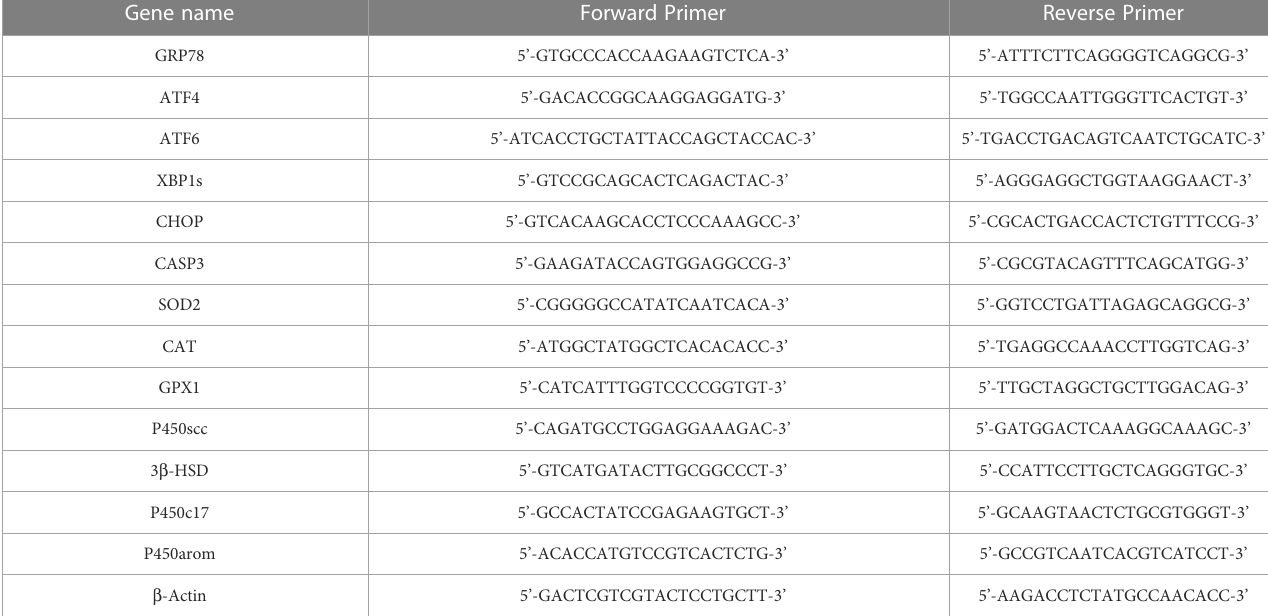
TABLE 1 Primers sequence used for mRNA